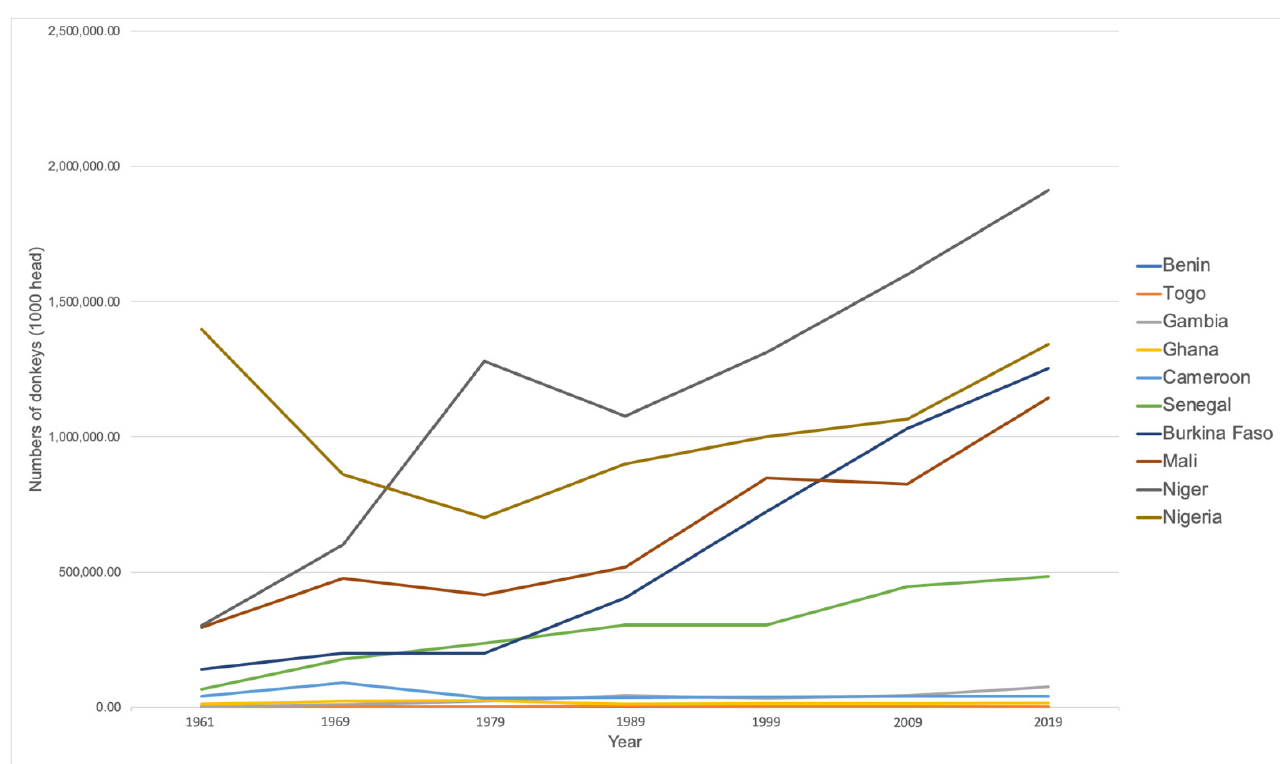
Figure 2. West African donkey populations 1961–2019 (FAO). Note: the quality of the data differs and includes official estimates, FAO estimates, unofficial figures, FAO data base and FAO imputation methodology. FAO. Source: FAOSTAT/asses, accessed 7 March 2021.